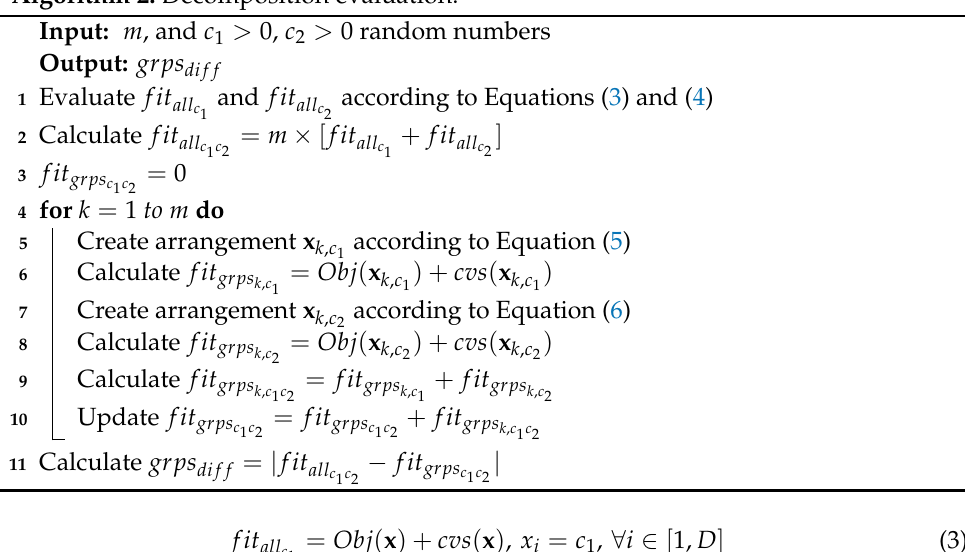
Algorithm 2: Decomposition